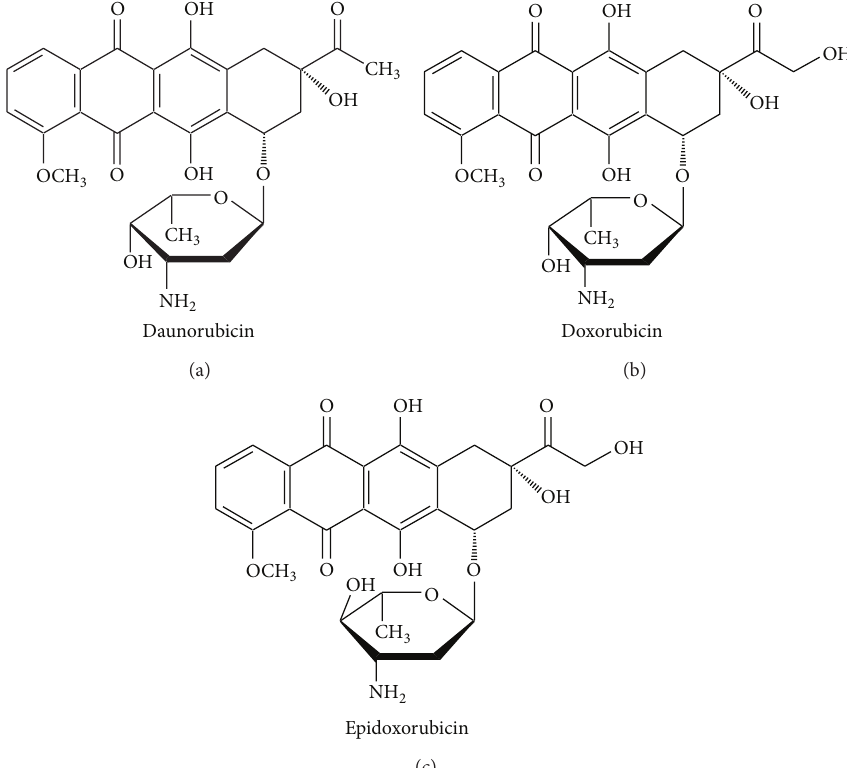
Figure 1: Chemical structures of daunorubicin, doxorubicin, and epidoxorubicin.